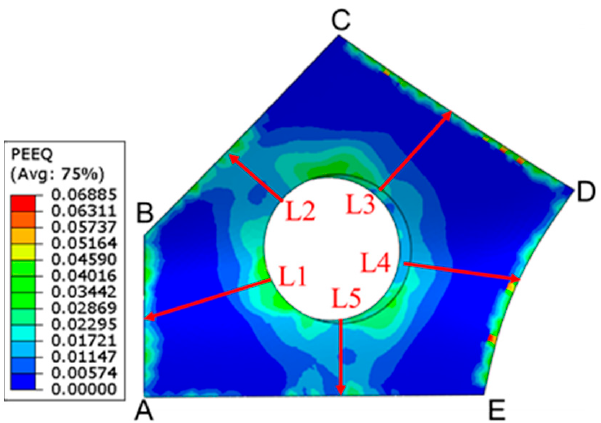
( e ) Figure 9. Von Mises stress after quenching and cold expansion of the central layer forging: ( a ) von Mises stress in region P1; ( b ) von Mises stress in region P2; ( c ) von Mises stress in region P3; ( d ) von Mises stress in region P4; ( e ) von Mises stress in region P5.